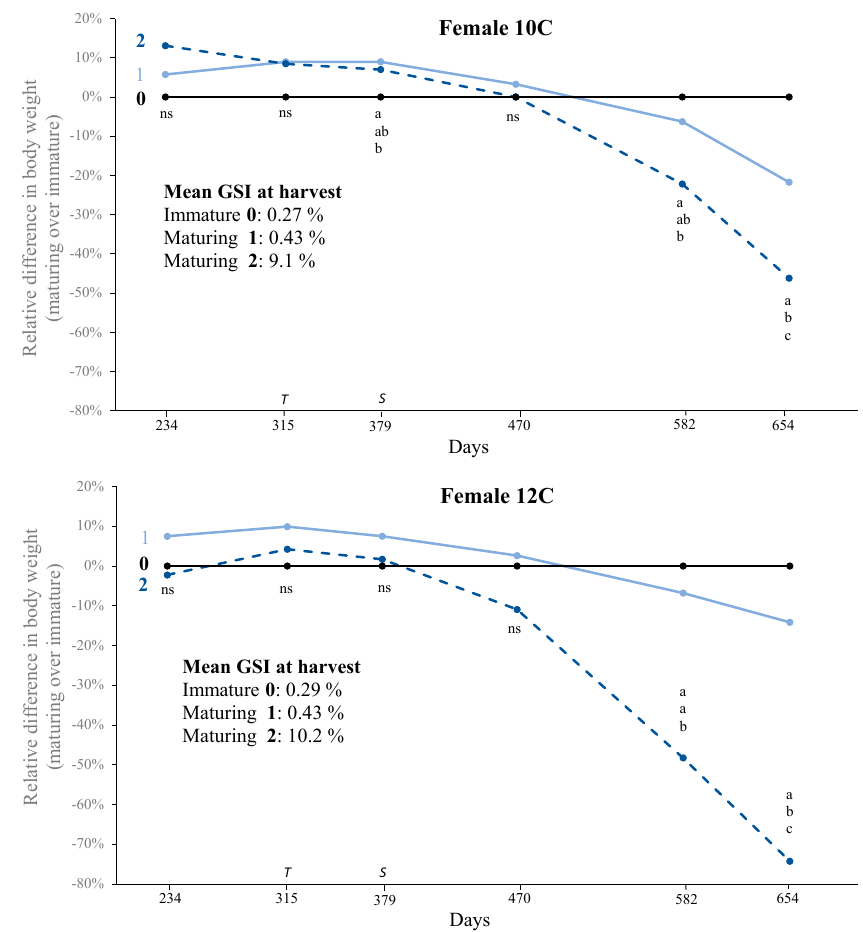
Figure 5. Body weight (W) progression of immature female Arctic charr in experimental groups 10C and 12C, relative to maturing conspecifics. The maturity stages are based on gonadosomatic indices (GSI) at harvest on day 654. Immature females in stage 0 had GSI within 0.15% and 0.35%, while females in stages 1 and 2 had GSI from 0.35% to 3.5%, and >3.5%, respectively. On day 315 all groups were acclimatized to 7 °C ( T ) and reared at 7–8 °C until harvest. On day 379 all groups were subjected to an abrupt increase in salinity from 4 to 22 ppt ( S ). Different lower-case letters denote significant differences between groups at the 5% level of significance.